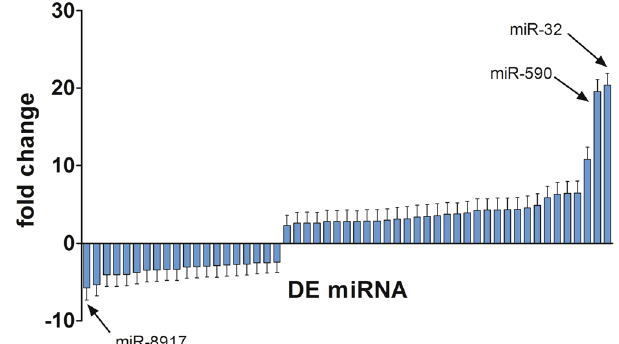
Figure 5. Normalized fold change for miRNAs upregulated or downregulated in infected horses as determined by DESeq2. Each bar represents a miRNA whose expression level was significantly different (FDR < 0.05) between the groups of infected and uninfected horses. Error bars represent standard error.